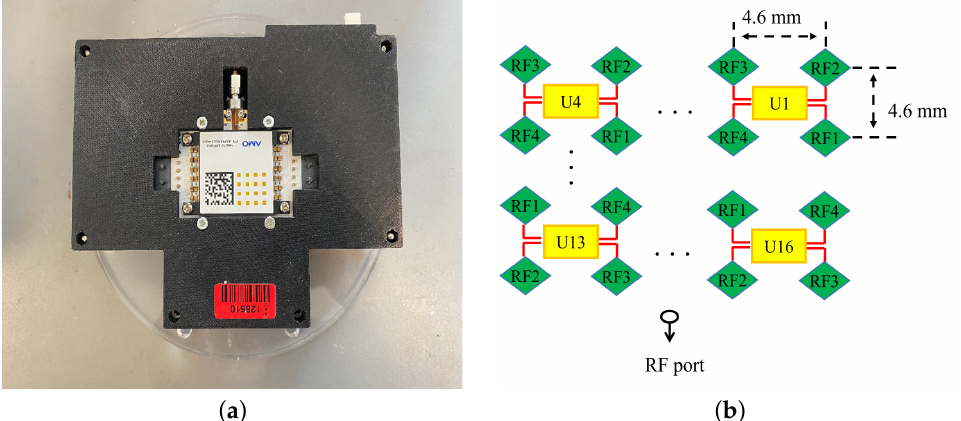
Figure 1. ( a ) Photograph and ( b ) chips and antennas layout of the 8 × 8 AiP